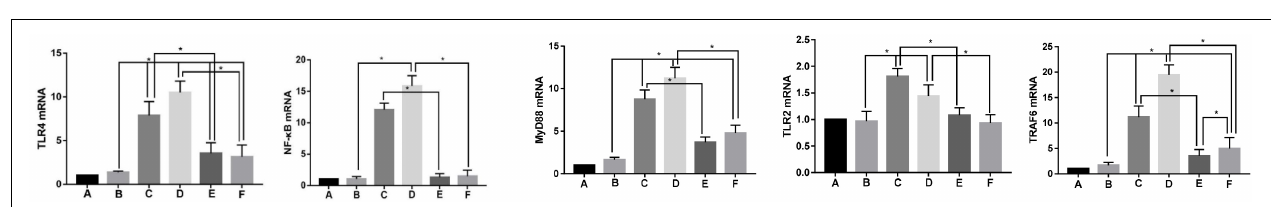
FIGURE 5 | Protein expression levels of TLR4, NF- κ B, MyD88, TLR2, and TRAF6 in the synovium of rabbit joints in each group. Note (A) Group B; (B) Group S; (C) Group M1; (D) Group M2; (E) Group EA1; and (F) Group EA2. * P < 0.05.